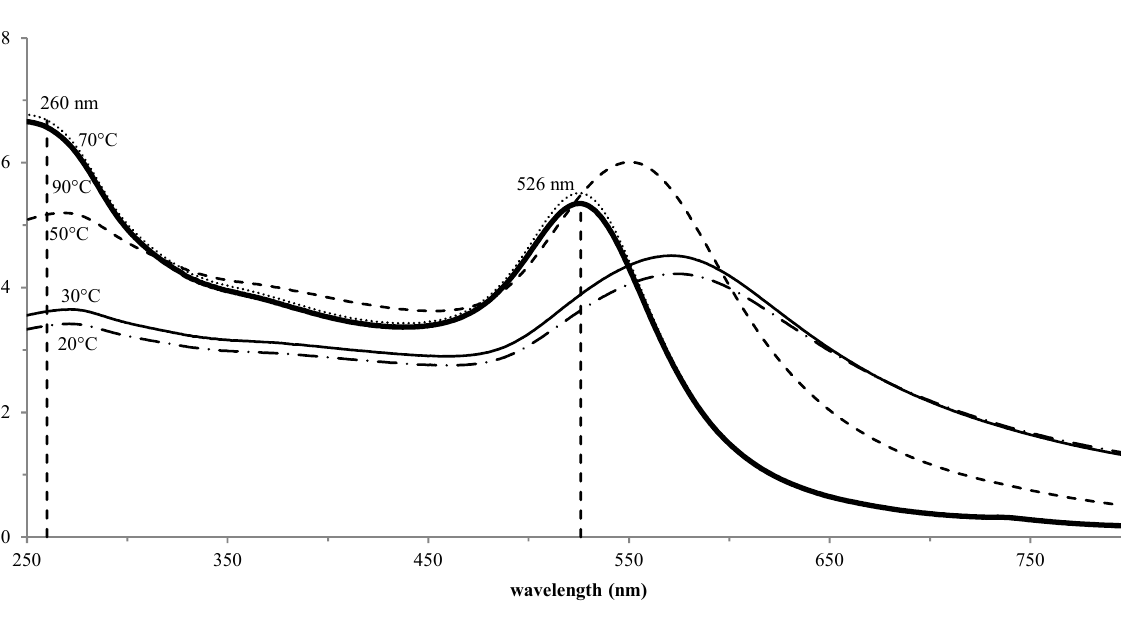
Figure A1. Absorption spectra during the cooling ramp of the assembly AuNPs-DNAA mixed with AuNPs-DNAT